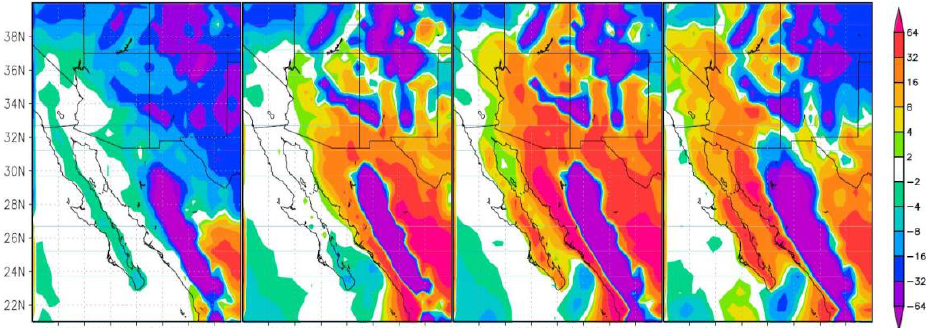
Figure 14. Differences of monthly mean precipitation (mm month −1 ) averaged over 1951–2010 period from left to right: June ( far left ), July ( middle left ), August ( middle right ), and September ( far right ). Differences are Modified KF minus Native KF, considering WRF domain 1 (35 km grid spacing).